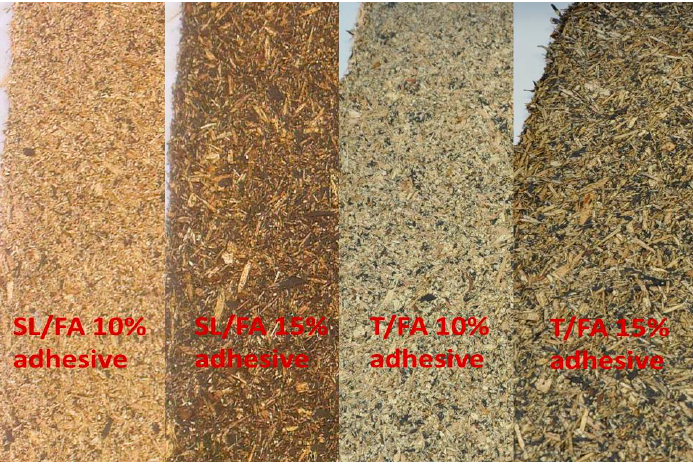
Figure 8. Particleboards: Spent-Liquor/Furfuryl alcohol with 10% and 15% of glue ( left side ) and Tannin-Furfuryl alcohol with 10% and 15% glue ( right side ).